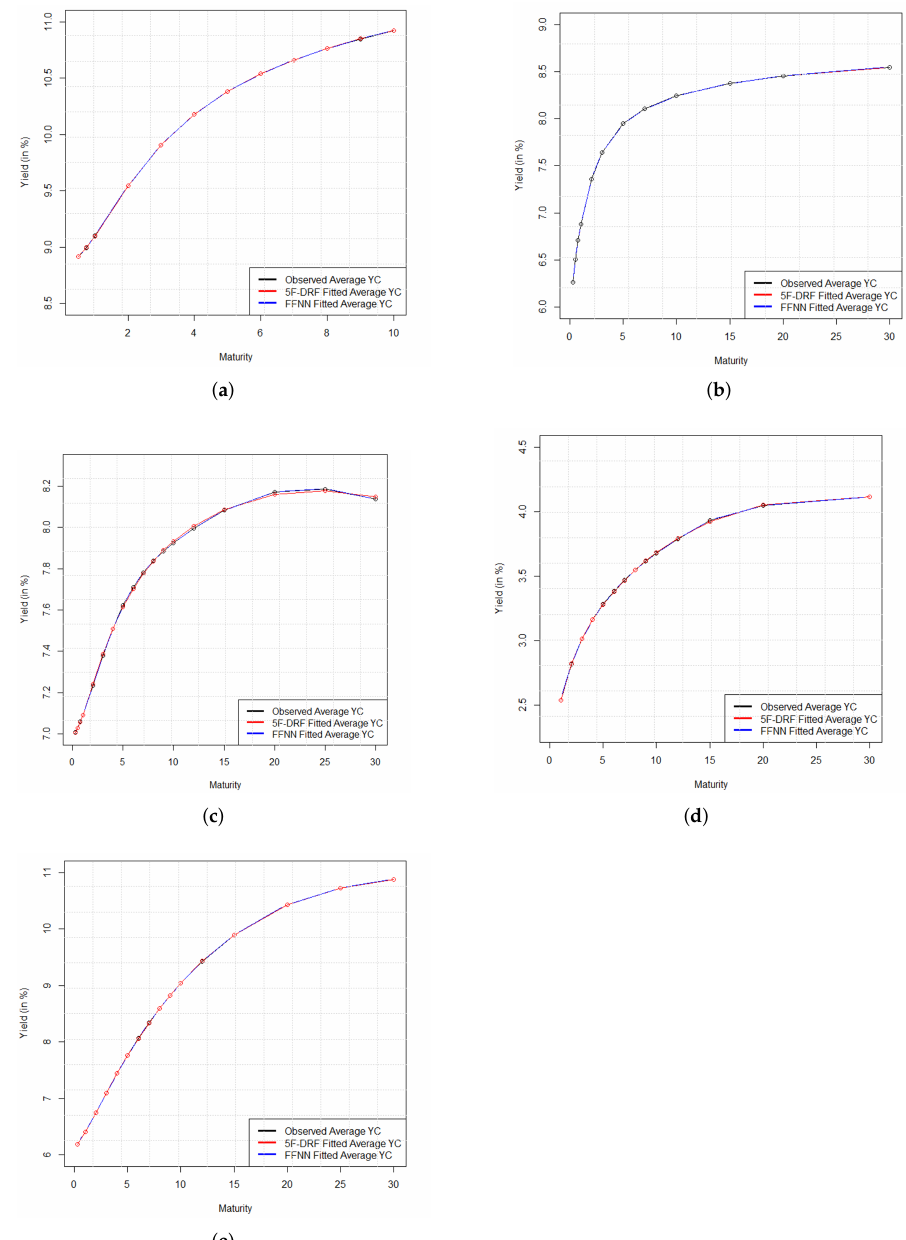
Figure 4. Average observable yield curve against average yield curves generated by the 5F-DRF (red) and FFNN (blue) models in the BRICS market. From top to bottom and from left to right, ( a ) is associated to Brazil, ( b ) to Russia, ( c ) to India, ( d ) to China, ( e ) to South